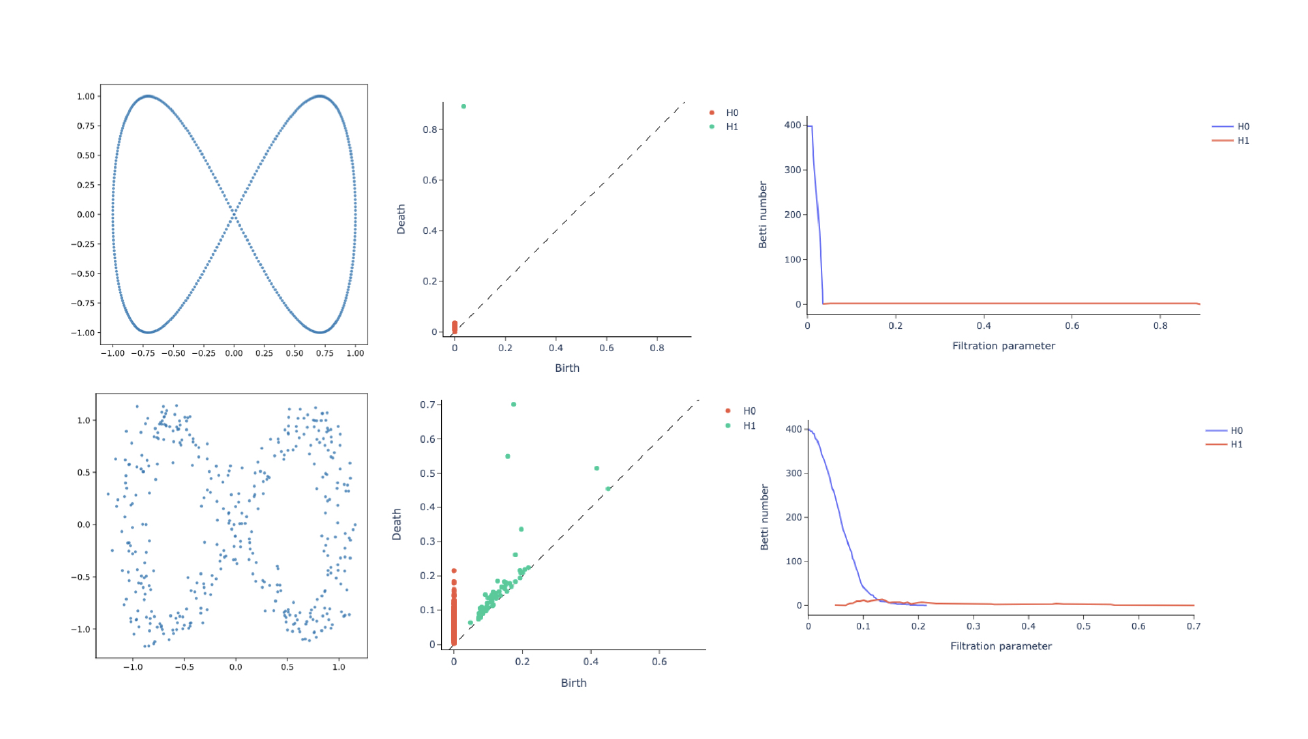
Figure 3. Topological descriptors on a lemniscate-shaped synthetic dataset with ( top ) and without ( bottom ) noise: dataset scatterplot ( left column ), persistence diagram ( central column ) and Betti curves for homology groups H 0 and H 1 ( right column ). Although it is still possible to appreciate the same topological structure, the persistence diagram for the noisy lemniscate has a cluster of points near the diagonal, representing non-persistent features of the input point cloud. The different spatial organization of the two structures is also reflected by the Betti curve for H 0, displaying a slower decay